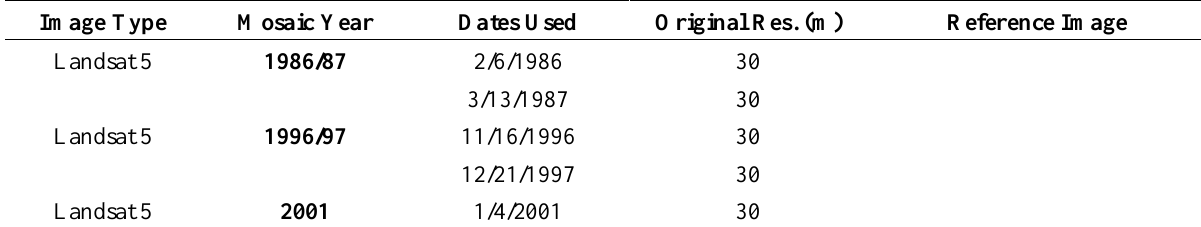
Figure A3. Pairs of hyperspectral reflectance spectra, taken from the training data for all nine forest types. See Table 2 for sample sizes and class name acronyms. This figure is similar to Figure 4, but displays variability in each class with pairwise comparisons to secondary forest. Lines show mean reflectance, with buffer polygons showing ± one standard deviation. Secondary forests (pink lines, yellow polygons) are compared against the other forest classes (black lines, gray polygons). Note the large amount of variation in spectral reflectance for each forest type. Table A1. Image information for the Landsat image stack (1986–2011) and the Hymap image mosaic (2005). The reference image for radiometric correction is indicated for each of the two imagery types: Landsat and